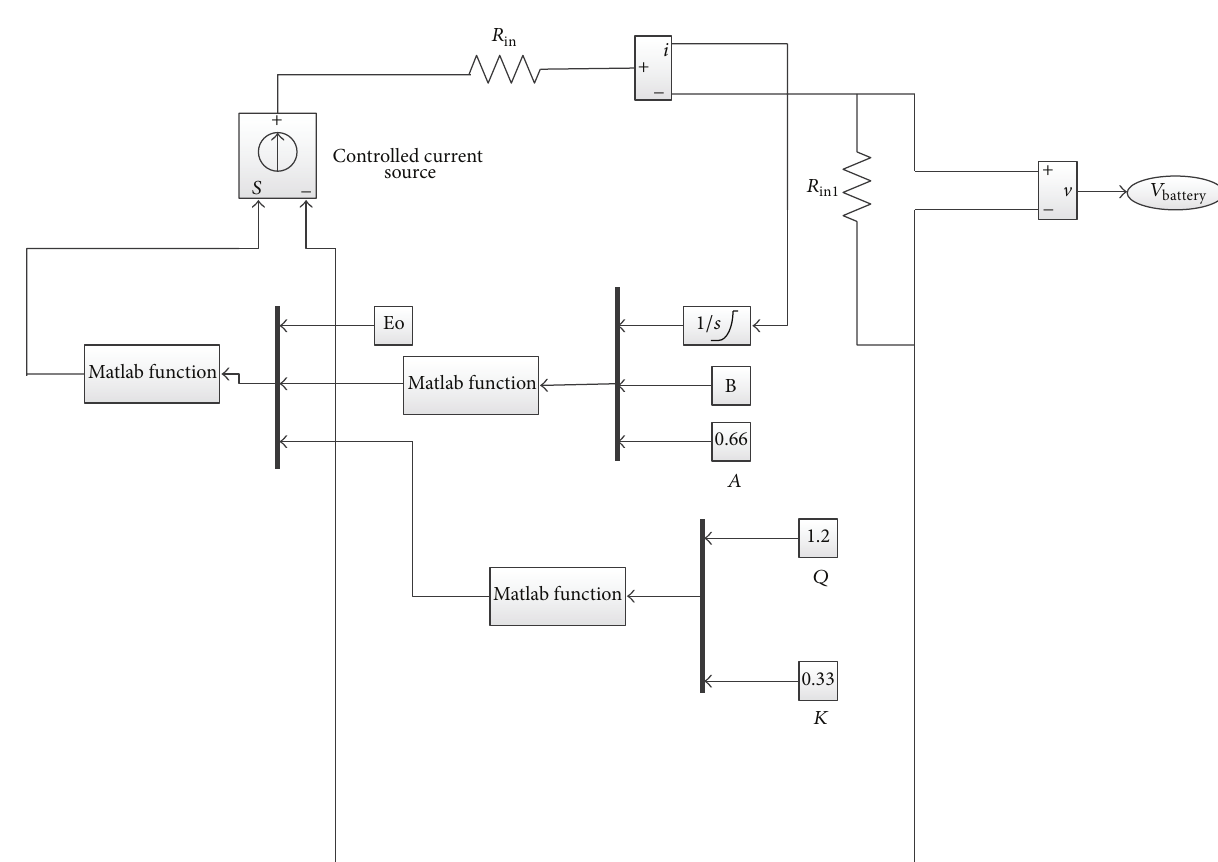
Figure 10: The Simulink diagram of the battery model.